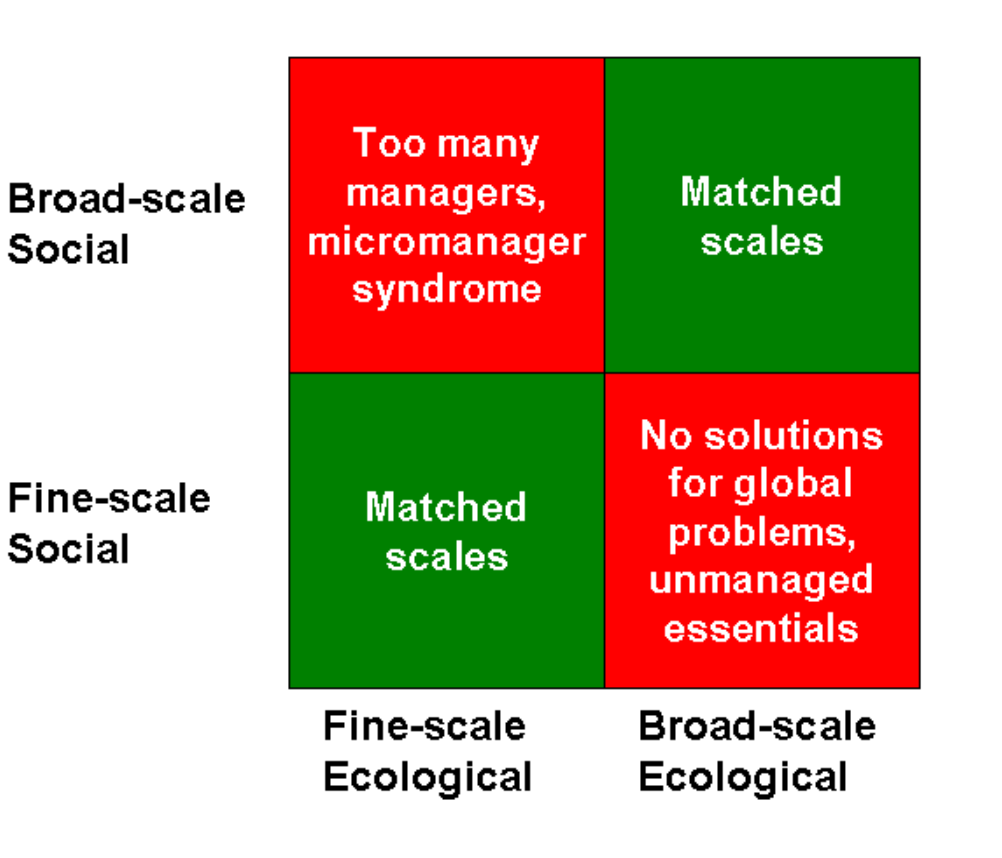
Fig. 1 . Consequences of mismatched spatial scales (indicated in red) between social and ecological